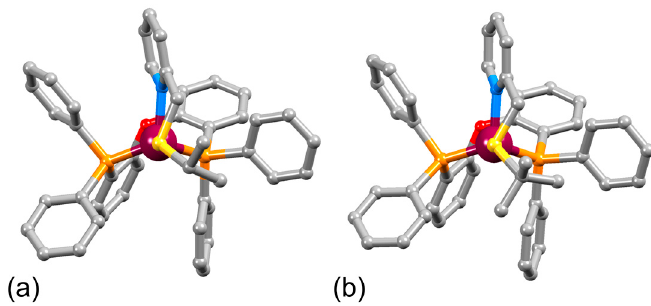
Figure 3. Comparison of the structures of the ( a ) [Cu(POP)( i PrSPy)] + and ( b ) [Cu(POP)( t BuSPy)] + cations, each viewed along the S–Cu bond.